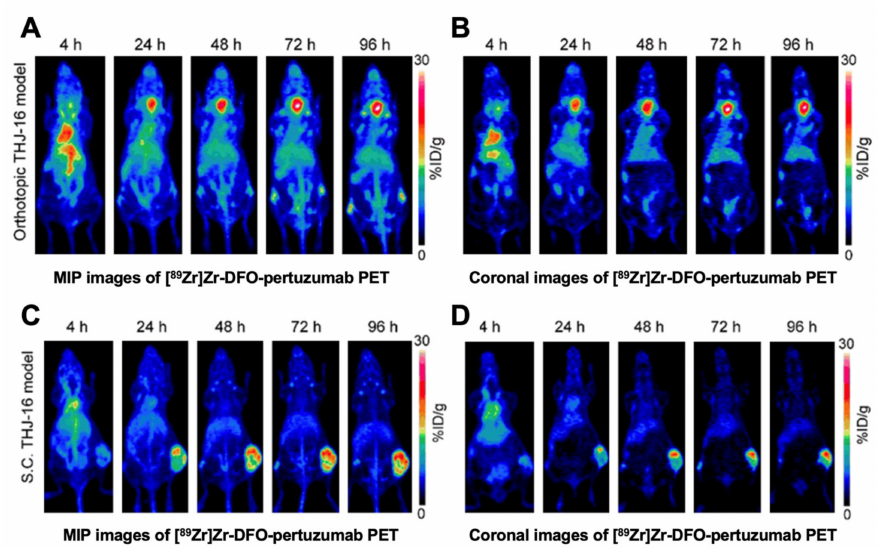
Figure 8. PET imaging with [ 89 Zr]Zr-DFO-pertuzumab in xenografts (cell line: THJ-16T). ( A ) Maxi- mum intensity projection (MIP) showed the ability of [ 89 Zr]Zr-DFO-pertuzumab for visualizing TCs in an orthotopic model. ( B ) Coronal imaging in an orthotopic model. ( C ) MIP in a subcutaneous model. ( D ) Coronal imaging in a subcutaneous model. Reproduced with permission from [114], copyright 2019 e-Century Publishing